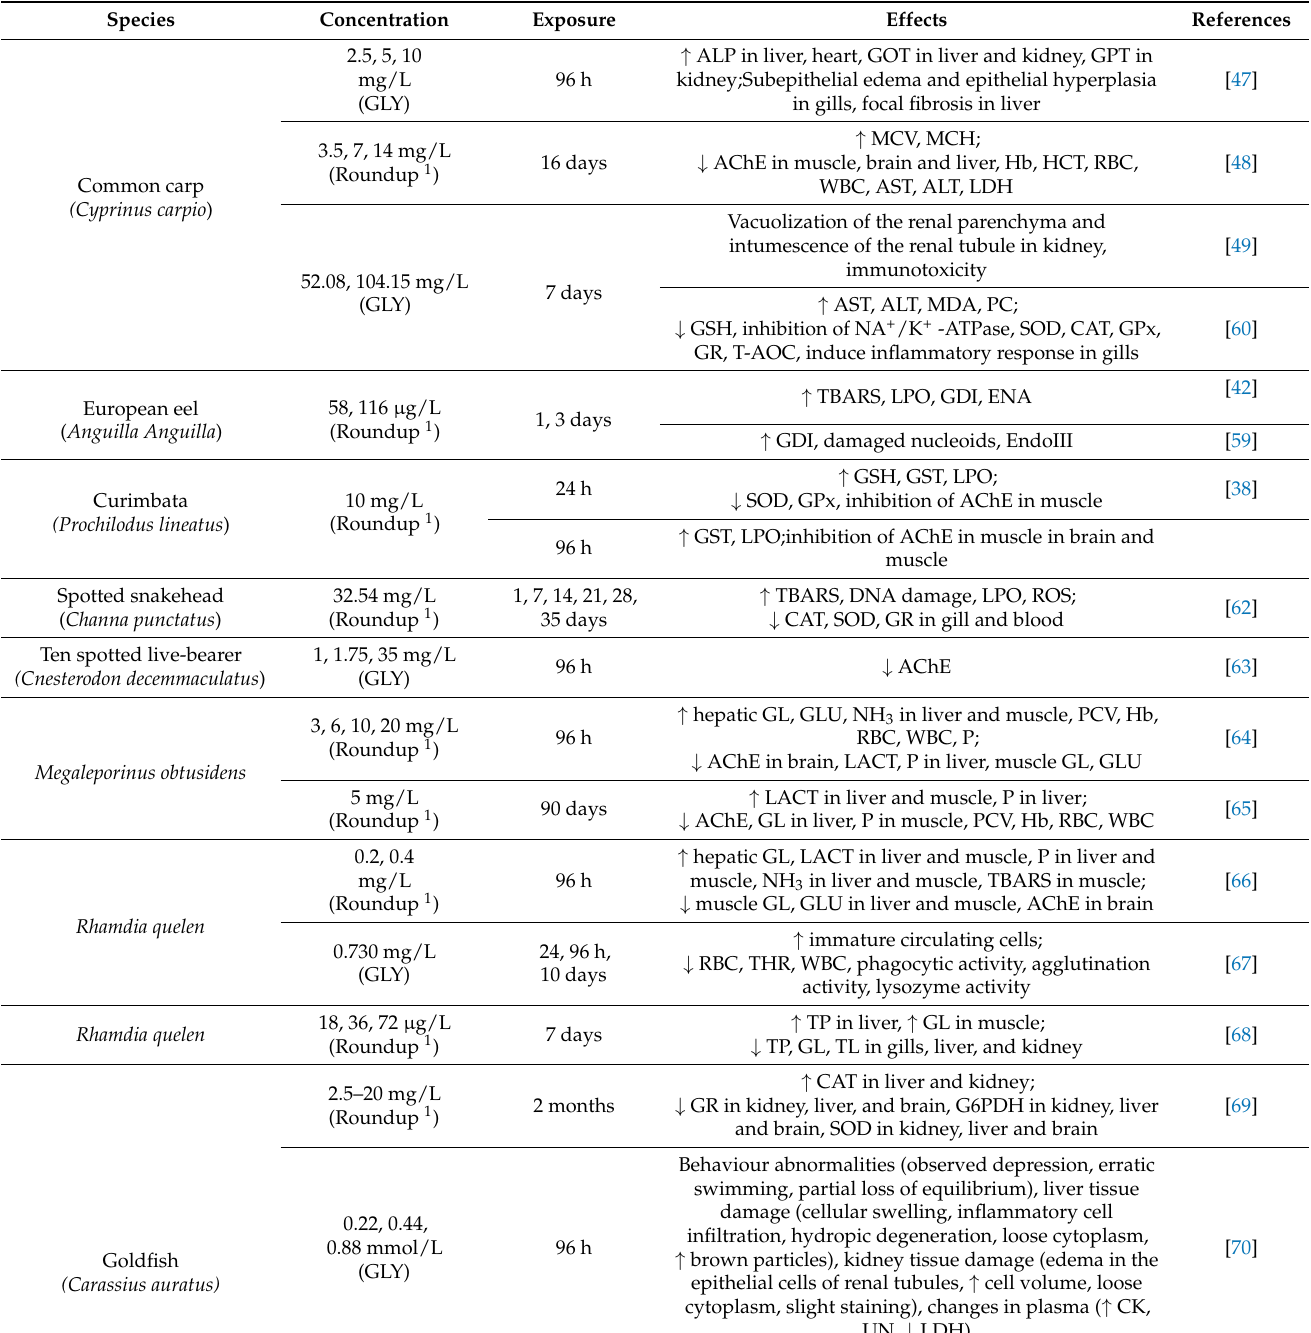
Table 4. Toxic effects of glyphosate and its commercial products on